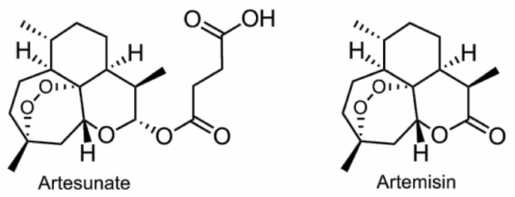
Figure 3. Artesunate and artemisinin.